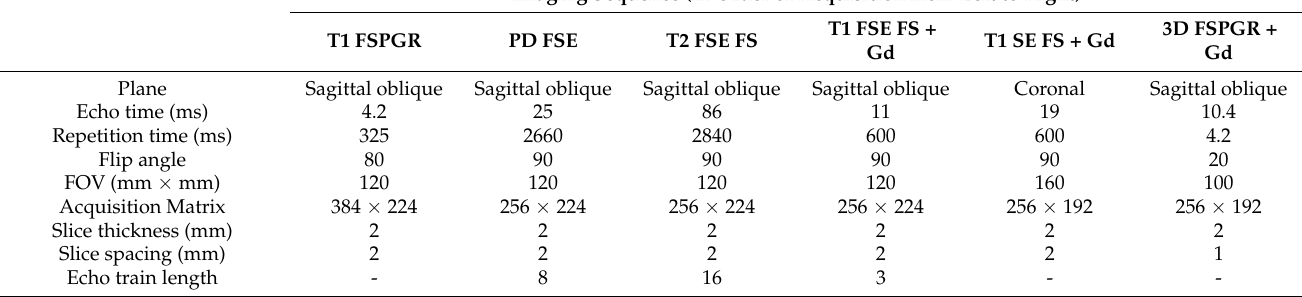
Table A2. Representative MRI protocol for the TMJ exams used in the reliability exercise. Abbreviations: FOV, field-of-view; FS, fat suppression sequence; FSE, fast spin echo; FSPGR, fast spoiled gradient recalled echo; + Gd, post gadolinium injection; mm, millimeter; ms, milliseconds; PD, proton density-weighted sequence; SE, spin echo.